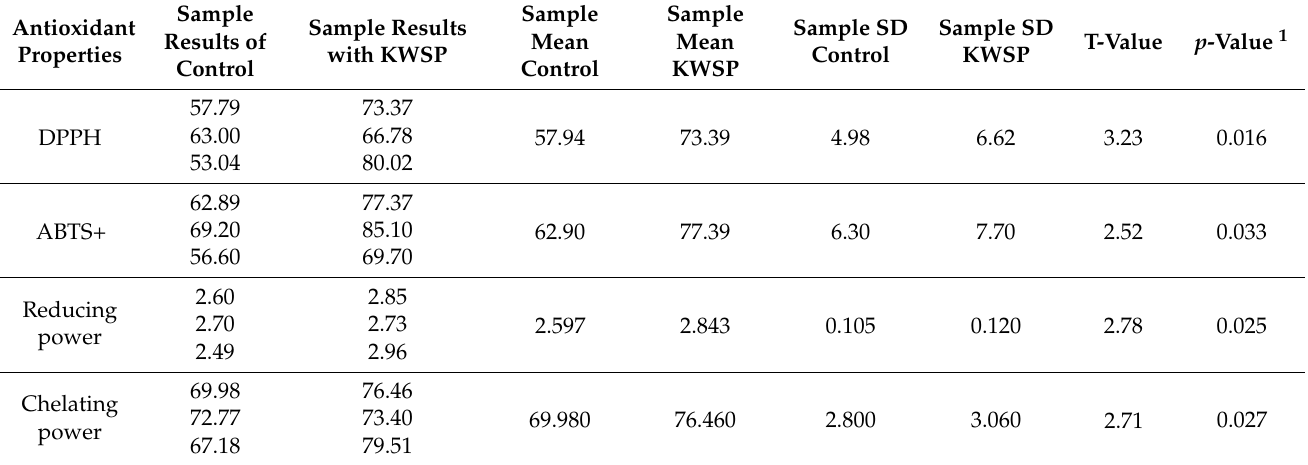
Table 5. Comparative statistical results between control sample and sample with